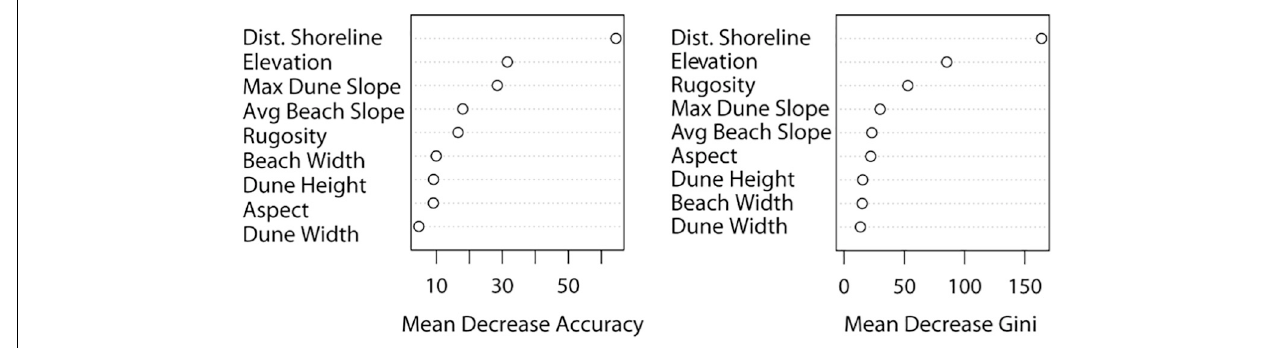
FIGURE 7 | Examples of beach profiles that would not be preferred for nesting due to (A) the wide, flat beach and (B) the narrow, steep beach and high average dune slope.